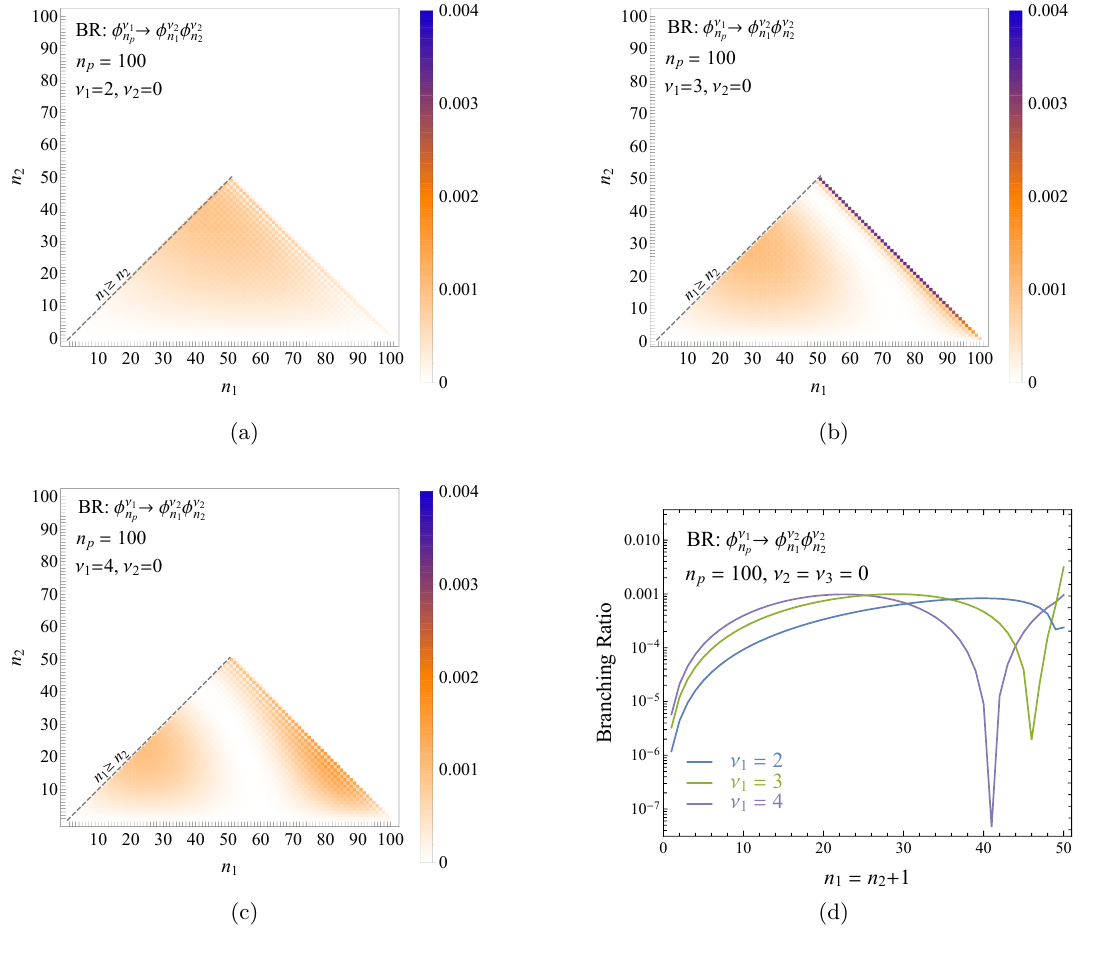
Figure 7 . The branching ratios of the n p = 100 mode for decays of the field corresponding to (a) ν 1 = 2 , (b) ν 1 = 3 , and (c) ν 1 = 4 into two ν 2 = 0 fields with KK modes n 1 , n 2 . The centralization of the plateau is a function of all ν , but generally the plateaus are more strongly centralized for i larger values of ∆ ν ≡ ν . The 1d projection of the branching ratios for all values of ν 1 − ν 2 − ν 3 along the n = n + 1 line is given in 1 2